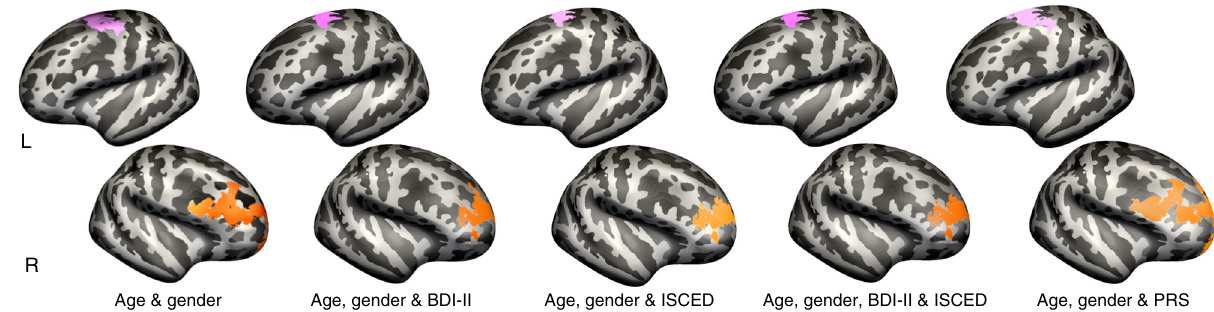
Fig. 6 Analyses of cortical folding with additional adjustment for a set of non-lifestyle covariates. The illustrations show the associations between the combined lifestyle risk score and cortical folding when correcting for a set of non-lifestyle covariates. The additional adjustments did not change the general associations between the combined lifestyle risk and decreased cortical folding within the left dorsal premotor cortex (dPMC) (pink) and the right ventro- lateral prefrontal cortex (vlPFC) (orange). BDI-II = depressive symptomatology, as measured with Beck ’ s depression inventory-II 36 , ISCED = educational level as measured with international classi fi cation of education 37 , PRS = polygenic risk